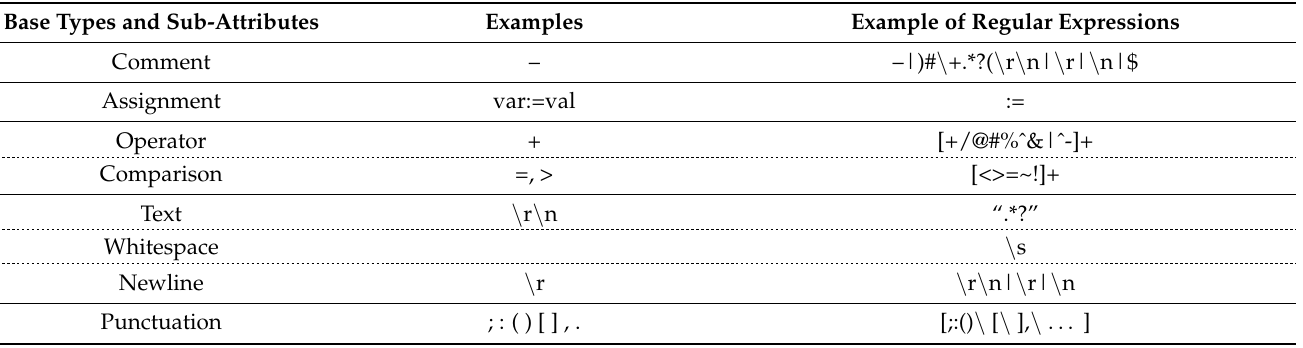
Table 1. Class attributes and their regular